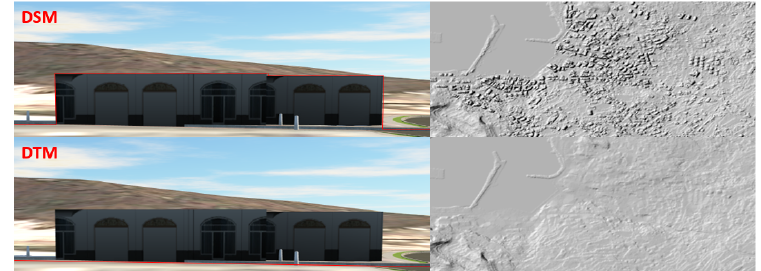
Figure 12. DTM vs. DSM resolution